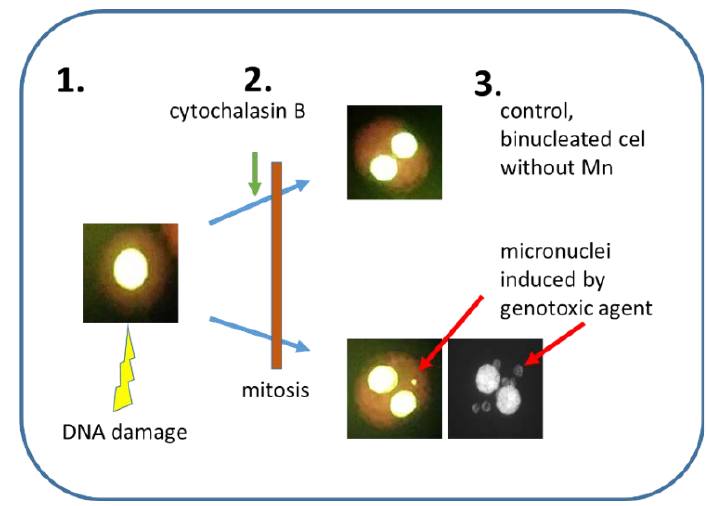
Figure 1. A principle of cytokinesis-block micronucleus assay. 1. Nucleus with damaged DNA. 2. Inhibition of cytokinesis by the addition of cytochalasin B. 3. The Mn frequency is scored in binucleated cells only. Upper part—control binucleated cells without Mn, lower part—two binucleated cells with 1 or 6 Mn visible in the cytoplasm.